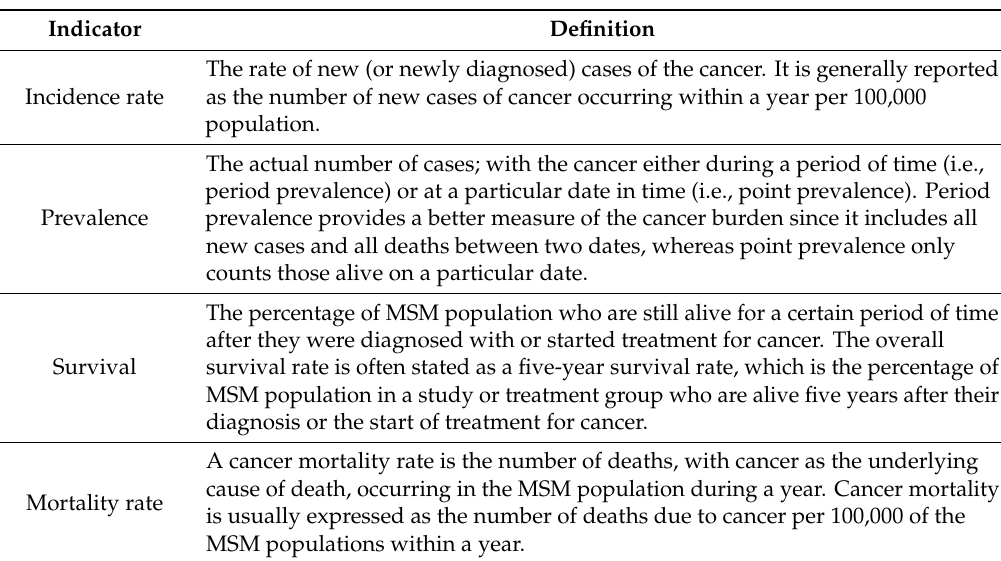
Table 1. Eligible Epidemiological Indicator and